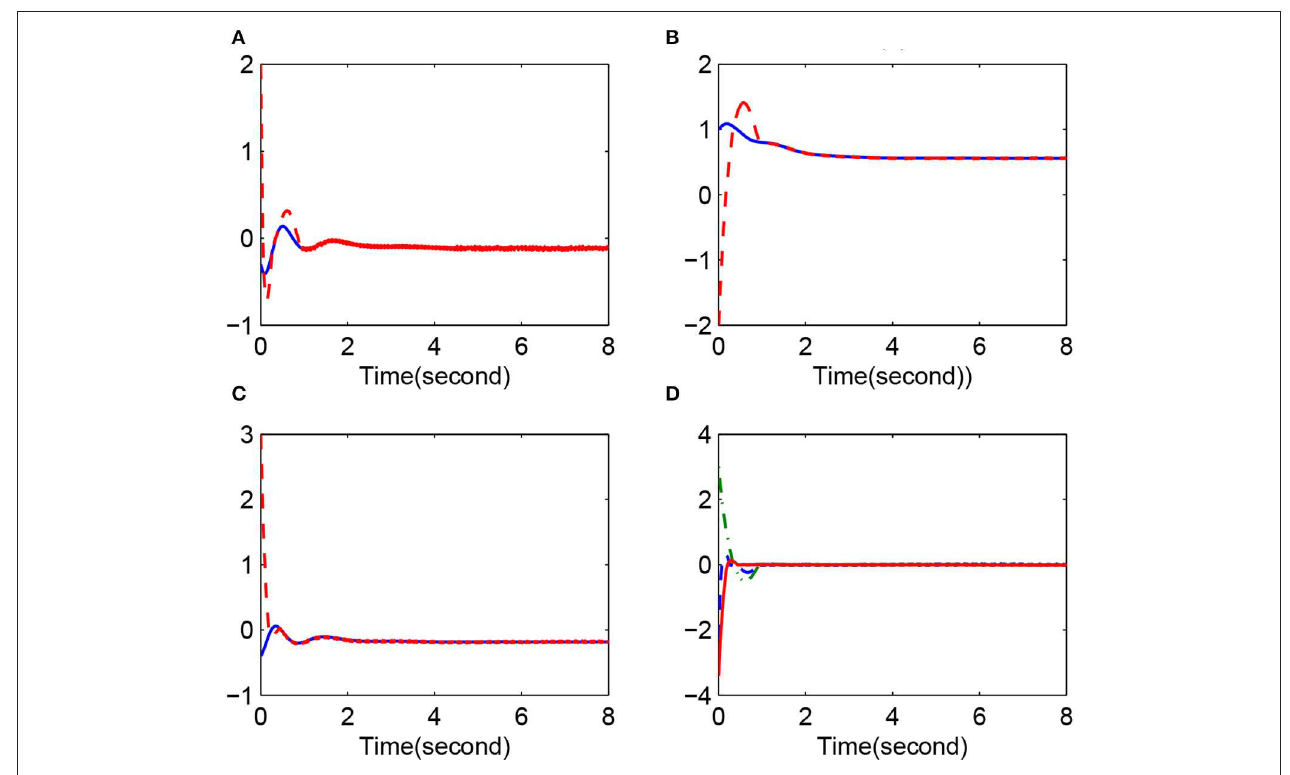
FIGURE 1 | Synchronization results of Case